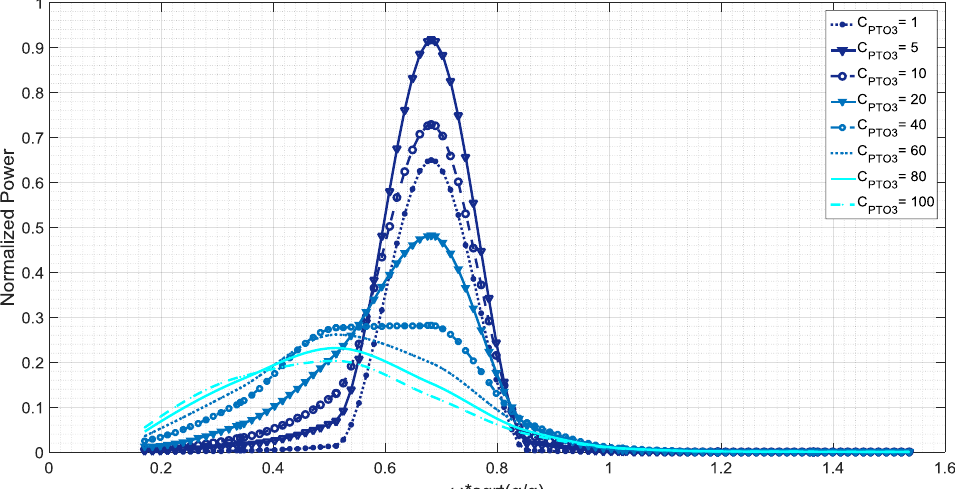
Figure 3. Normalized power output by the reference cylindrical heaving WEC ( a/h = 1/3.5, T/a = 3/2, d/h = 4/7) over the variable bottom ( h 1 = 1.2 m, h 3 = 0.8 m, α bot = 0.5) for different PTO damping d / h = 4 / 7) over the variable bottom ( h 1 = 1.2 m, h 3 = 0.8 m, α bot = 0.5) for di ff erent PTO damping C  [1, 5, 10, 20, 40, / C B b  considered here are configurations. Indicative values of the configurations. Indicative values of the C PTO 3 = B S 3 / b 33 considered here are C PTO 3 = [1, 5, 10, 20, 40, 3 PTO 3 3 33 PTO S 80, 80, 100].